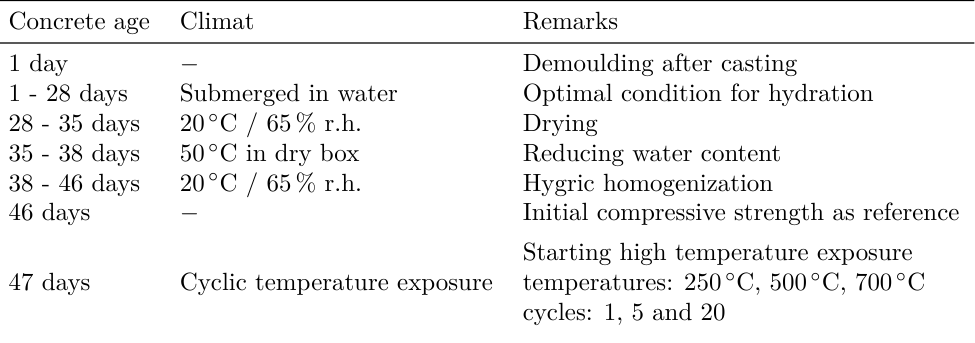
Table 2. Overview of conditioning